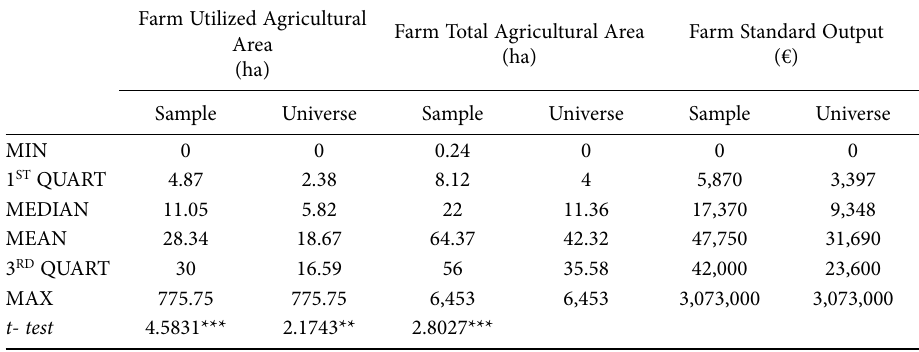
Table 2 . Mugello - Comparison between the geo-referenced sample and the universe. Farm Utilized